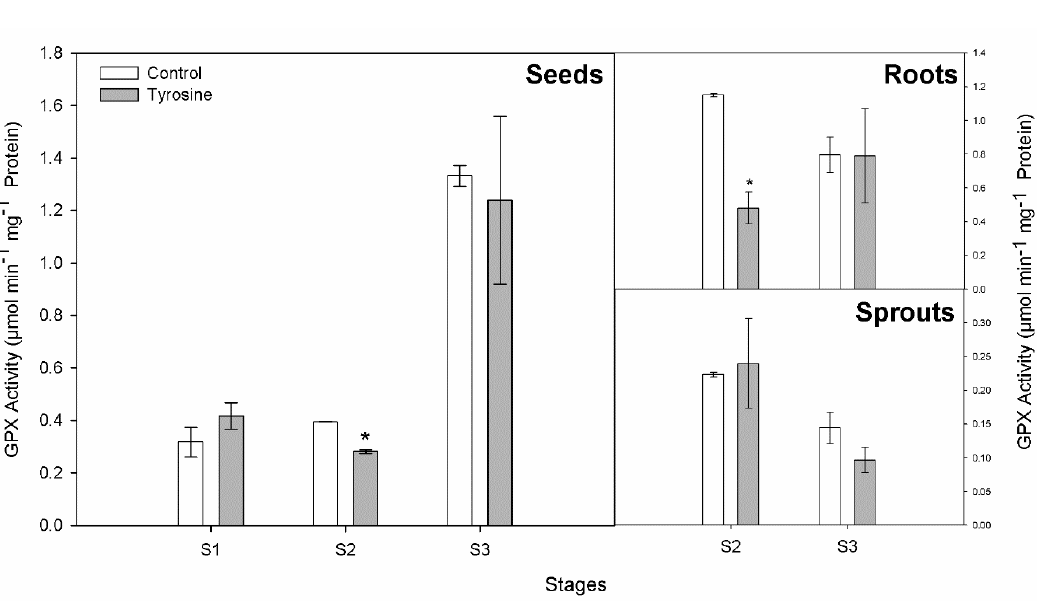
Figure 3. Effect of tyrosine treatment on guaiacol peroxidase (GPX) activity in V. faba seeds, roots, and sprouts at the early stages of development: S1: 3–4 days, S2: 8–9 days, and S3: 2–4 leaves. The bars indicate ± standard error ( n = 3). “*” indicates significant differences between controls and tyrosine treatments according to Tukey ( P <